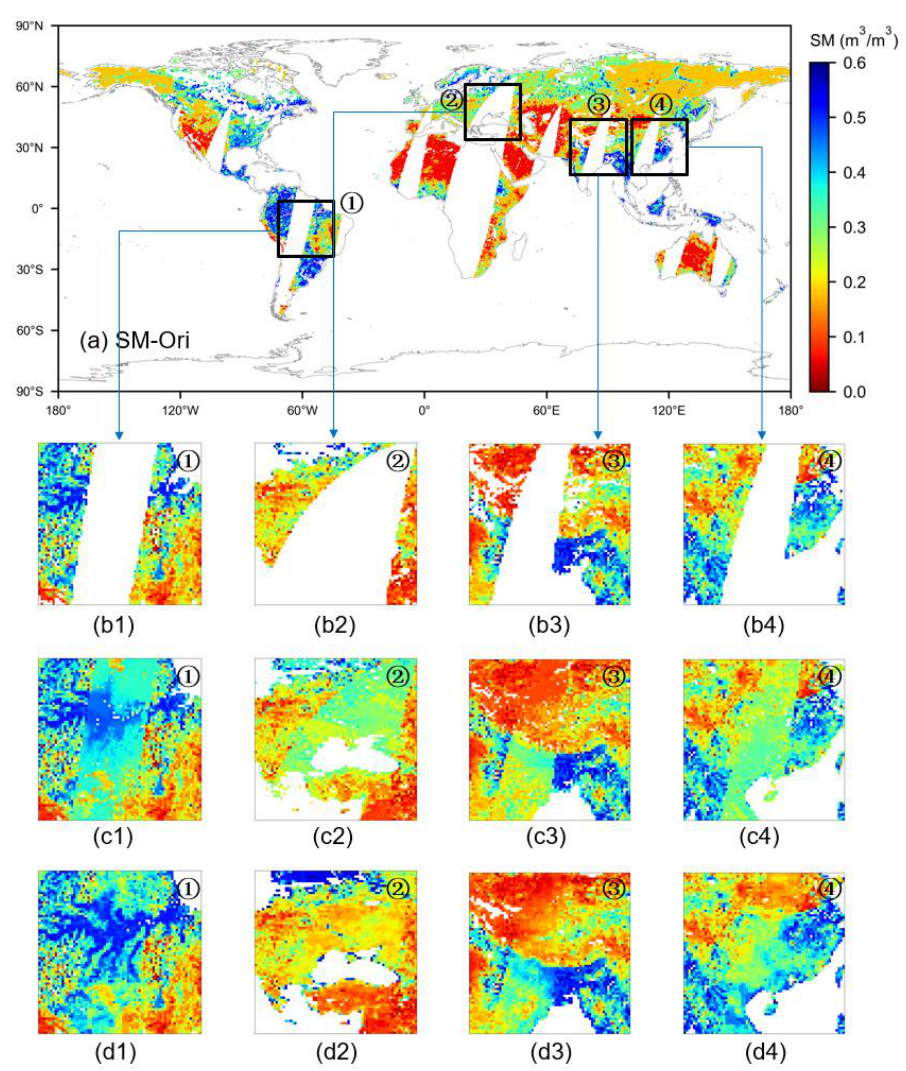
Figure 8. Comparison of the soil moisture gap-filling results by different methods at four selected regions on 10 July 2011, with original global SM ( a ). The top panel shows the original surface soil moisture ( b1 – b4 ), and the middle and bottom panels show the gap-filled surface soil moisture values obtained by the traditional method ( c1 – c4 ) and the pixel-wise method developed in this study ( d1 – d4 ).